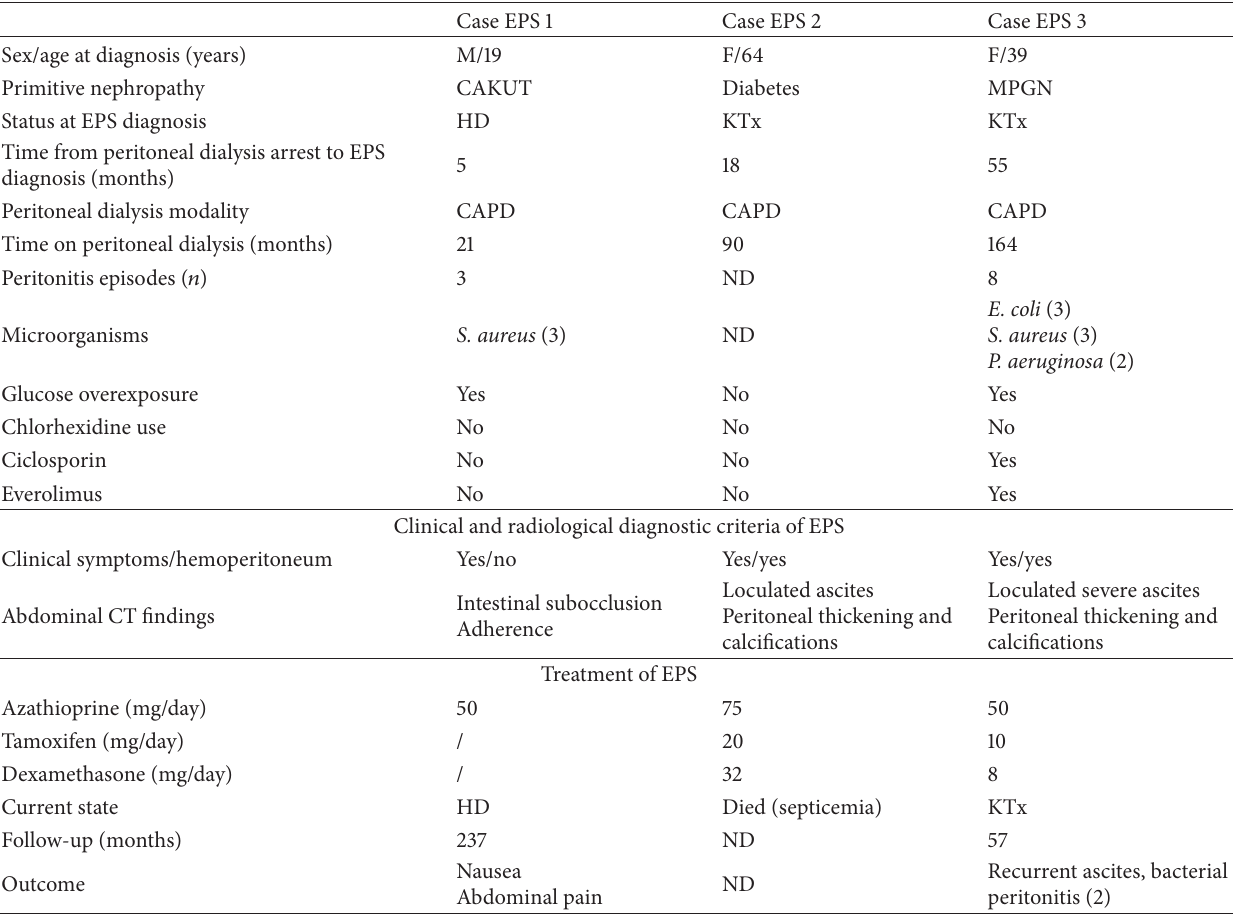
Table 2: Patients with encapsulating peritoneal sclerosis: epidemiological characteristics, diagnostic criteria, risk factors, treatment, and